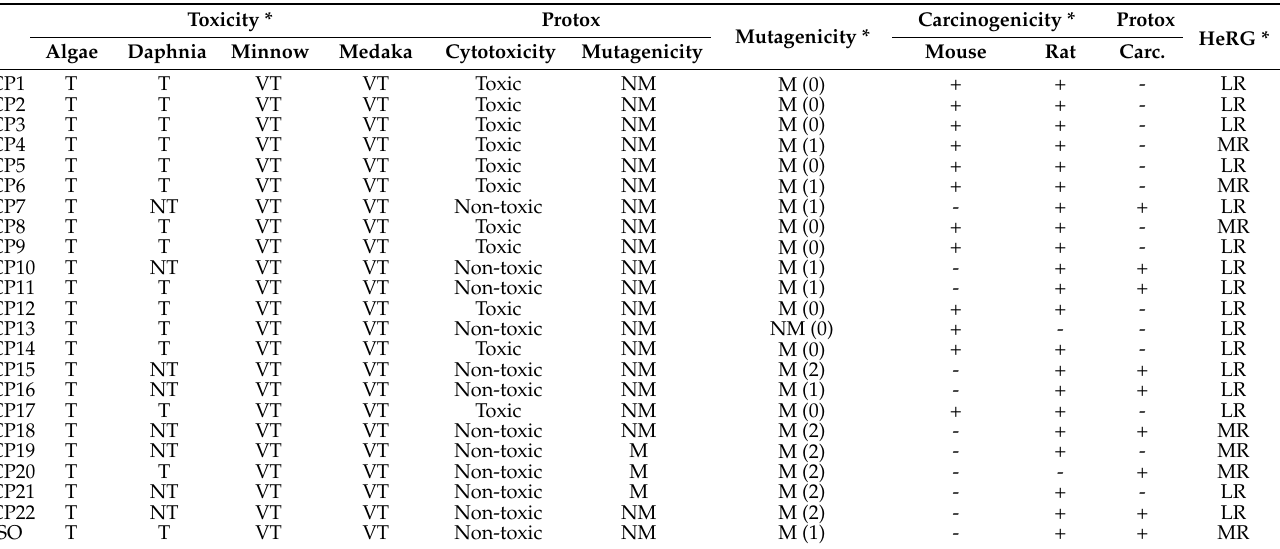
Table 2. Isoeleutherin analogues and their toxicity.